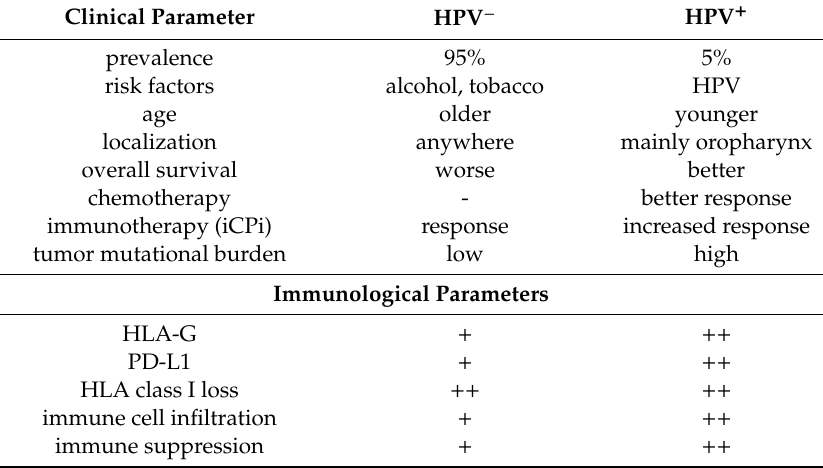
Table 1. Distinct clinical and immunological features of HPV − and HPV +